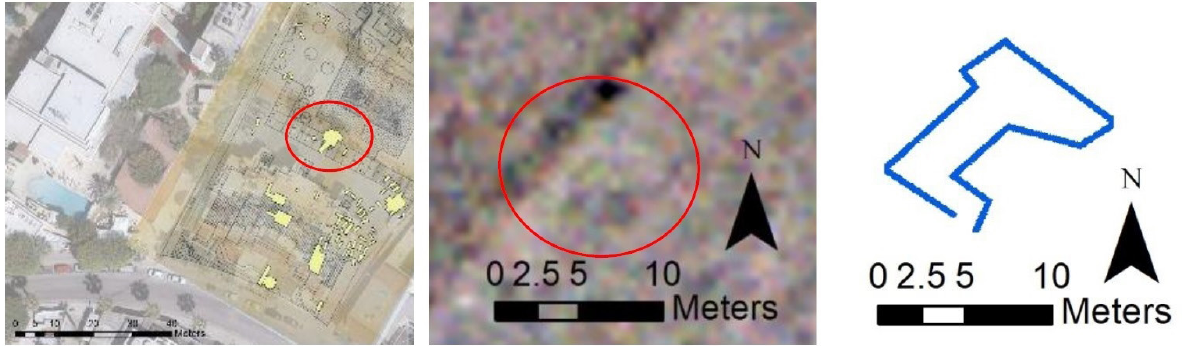
Figure 8: Correlation between known georeferenced tombs (left; Lysandrou et al., 2018) and near-surface archaeological proxies detected in the 1968 aerial photograph (middle); digitisation of the detected feature (right). (Background image: Aerial Orthophoto 2014 overlaid with the cadastral map with the georeferenced tombs (left); rectified 1968 aerial photograph